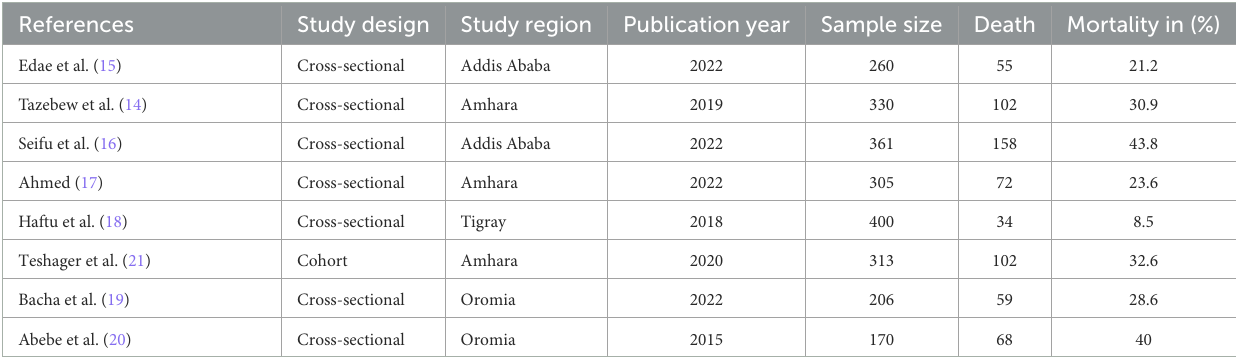
TABLE 1 Characteristics of included studies of pediatric patients admitted to a pediatric intensive care unit in Ethiopia.